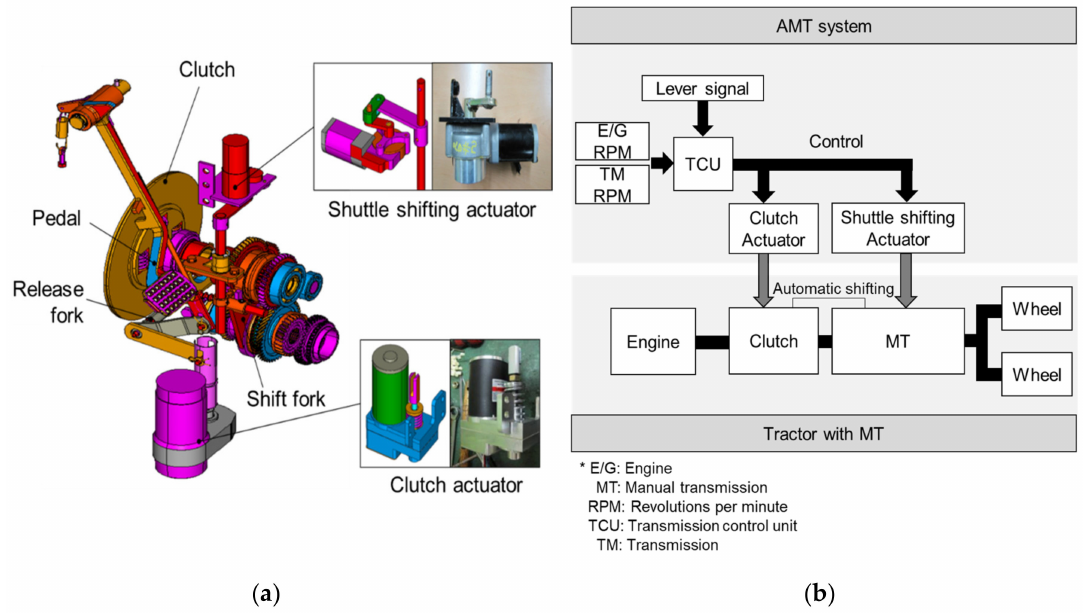
Figure 2. ( a ) AMT system layout including shuttle shifting actuator and clutch actuator; and ( b ) schematic of the AMT system combined with a manual